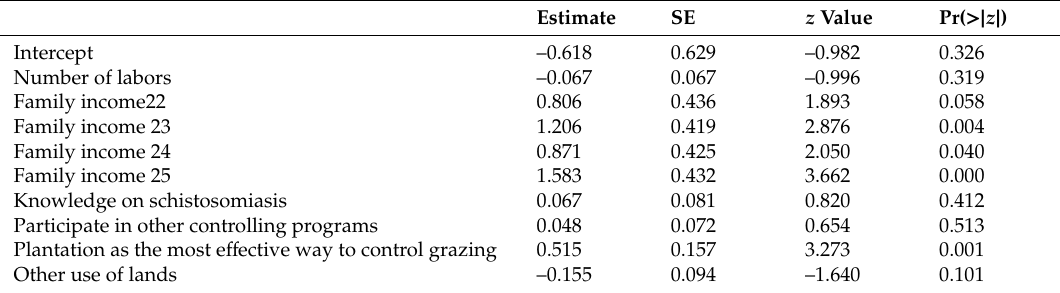
Table 6. Estimated regression parameters, standard errors, z -values, and p -values for the GLMM model.